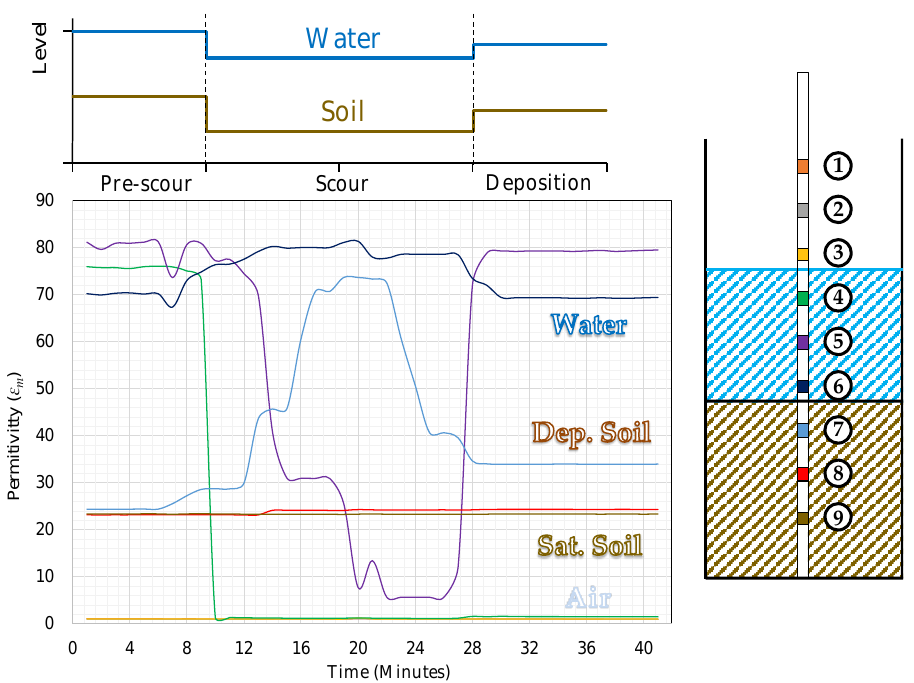
Figure 11. Permittivity ε m recorded by the nine sensors during the static scour test.